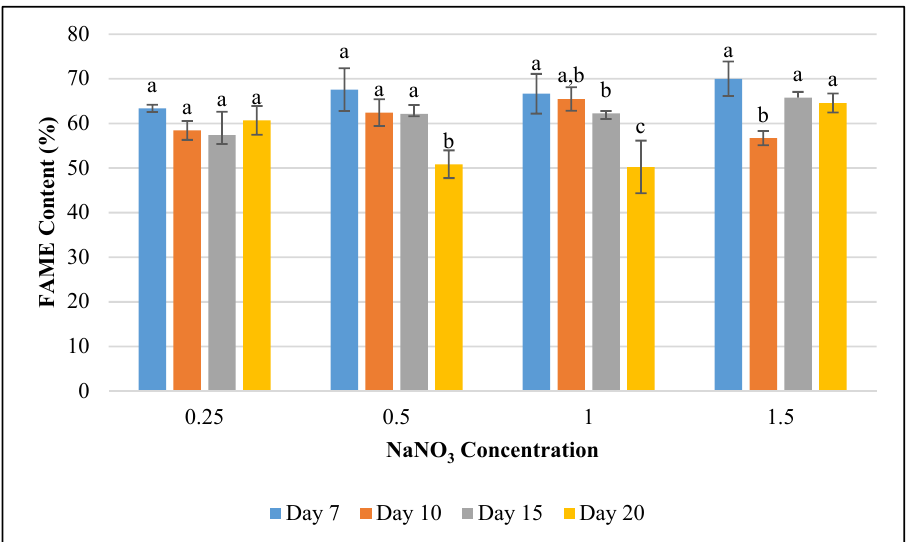
Figure 3. Fatty methyl ester composition (FAME) of Fremyella diplosiphon grown over ( A ) 7, ( B ) 10, ( C ) 15, and ( D ) 20 days in media containing 0.25, 0.5, 1.0, 1.5 g L − 1 sodium nitrate (NaNO 3 ). Bars represent the average % relative content of specific FAME species (± standard error) for three biological replicates of each nitrate treatment. Different letters above bars indicate significant differences in FAME species abundance between varying nitrate treatments ( p < 0.05).